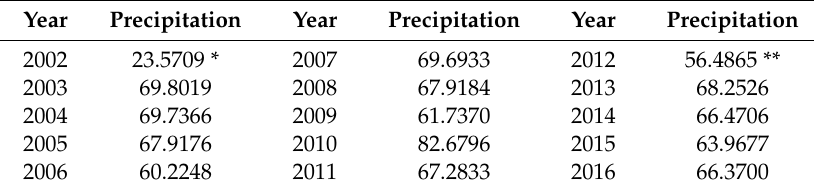
Table 1. The area-averaged annual total precipitations on the Tibetan Plateau in terms of the equivalent water thickness (cm).